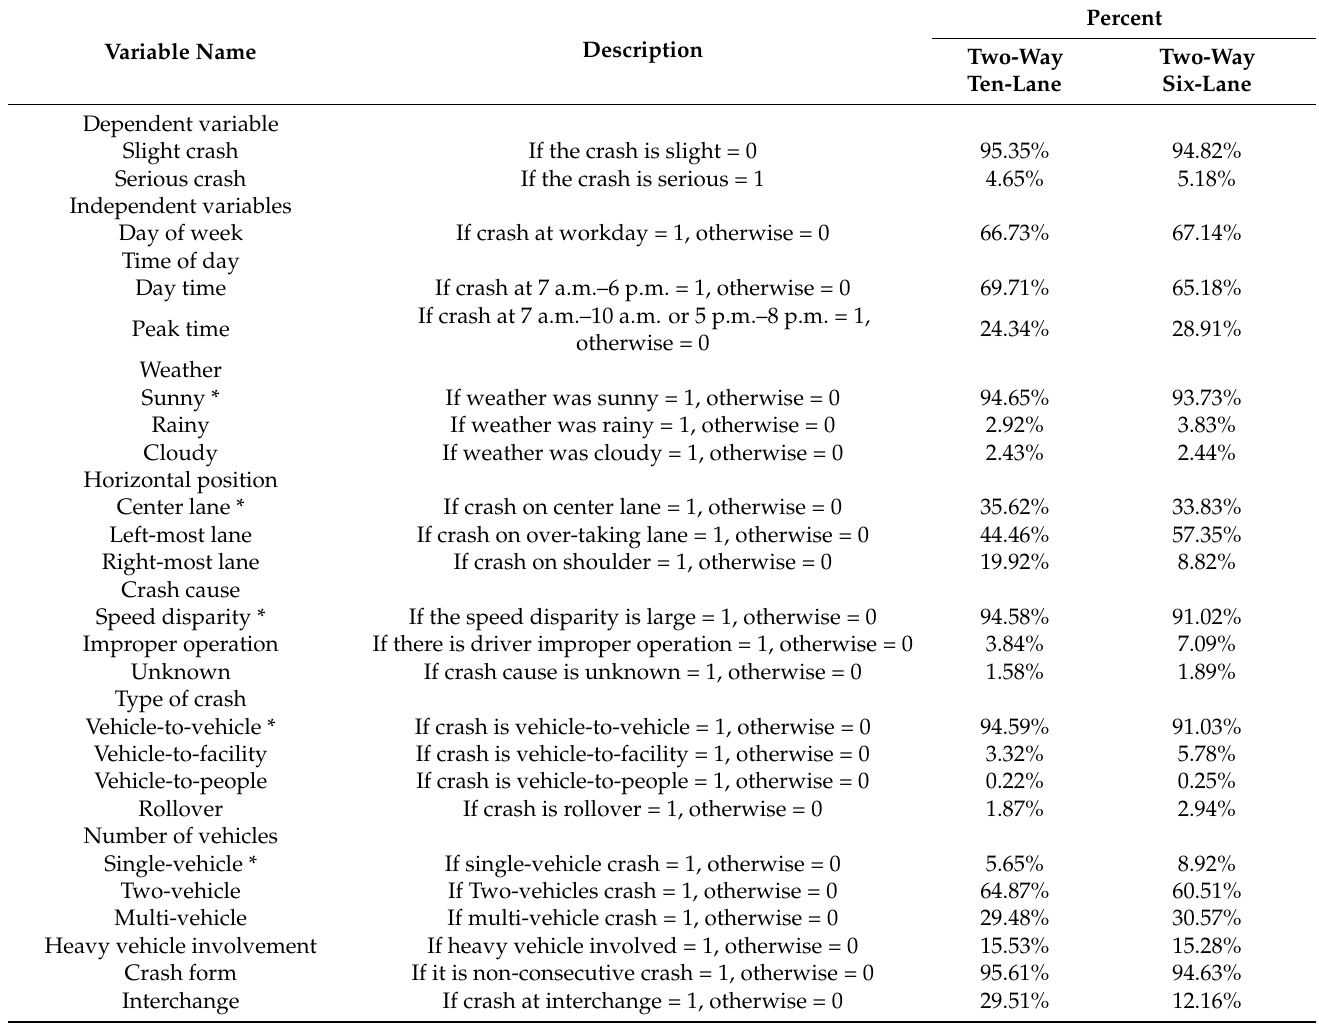
Table 1. Descriptive statistics of